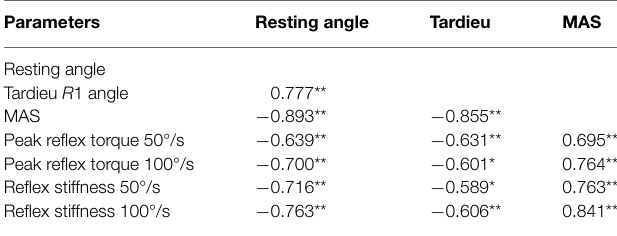
TABLE 2 | Correlations among resting angle, Tardieu R 1 angle, MAS and biomechanical parameters: peak reflex torque and reflex stiffness . Parameters Resting